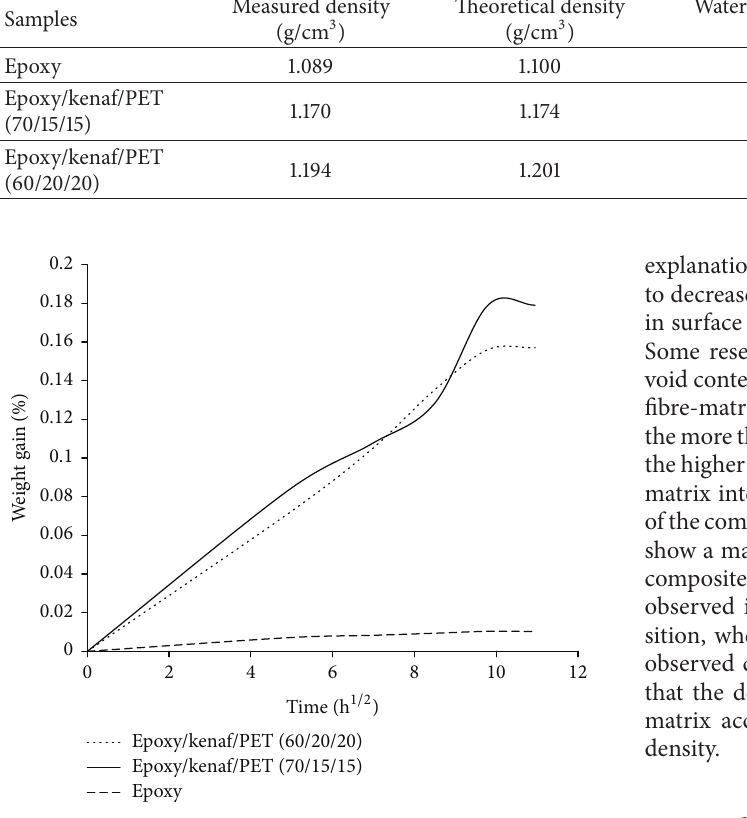
Figure 20: The water absorption behaviour of the interwoven hybrid